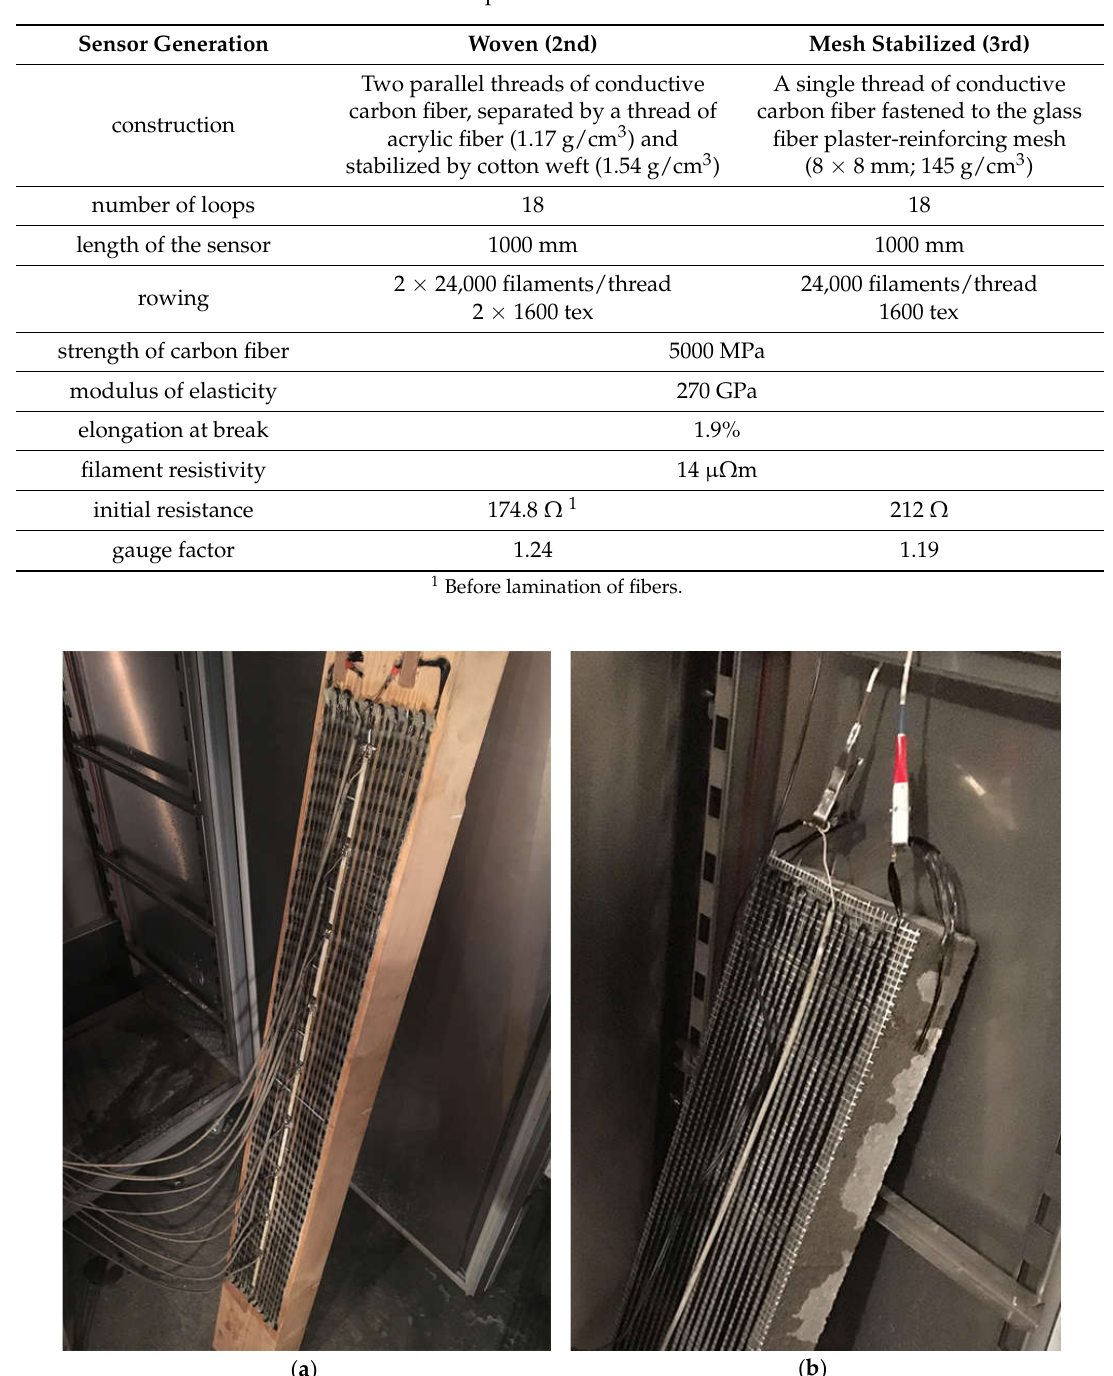
Table 1. Properties of the textile sensor.